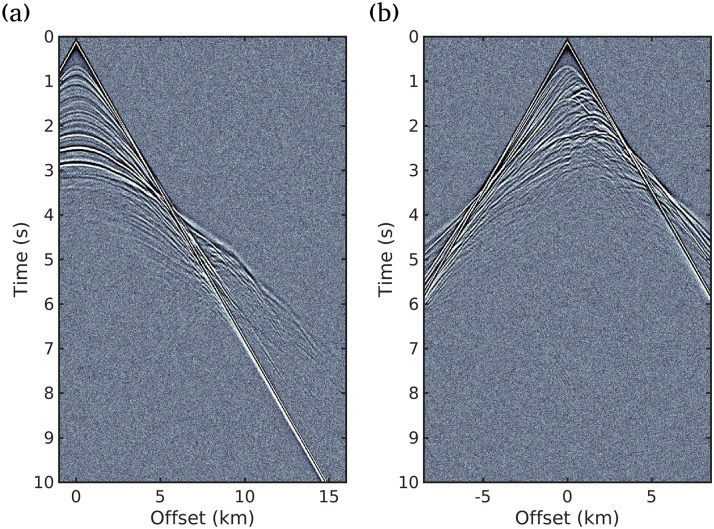
Example of the observed data: Seismograms of the 5th (distance 0.9km) and 42nd (distance 8.3km) seismic sources.